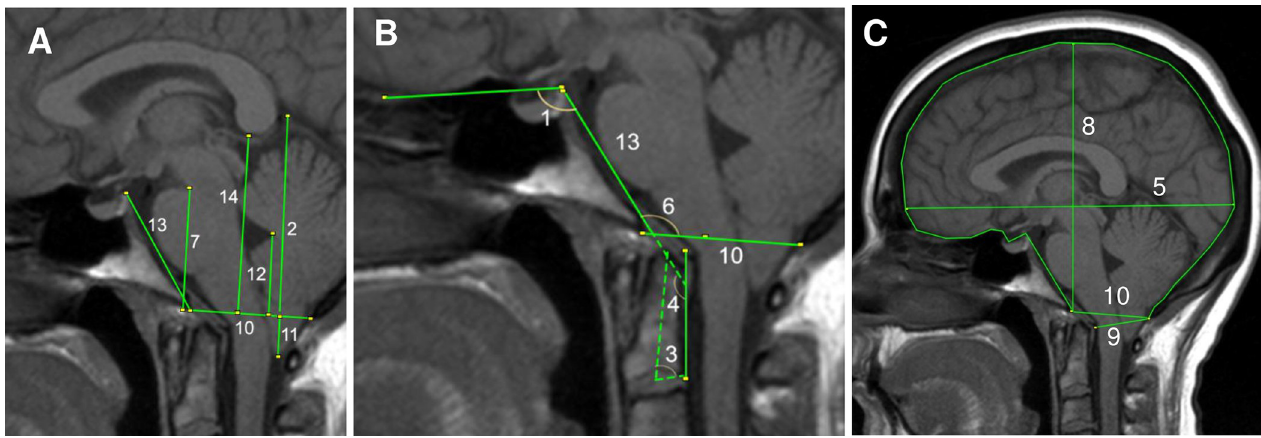
Fig 3. Fourteen morphometric measurements taken on a midsagittal T1-weighted MRI. A: 2-Posterior cranial fossa height, 7-pons height, 10- McRae line length, 11-tonsillar position, 12- fastigium height, 13- clivus length, 14-corpus callosum height. B: 1-Basal angle, 3-odontoid angle, 4-Wackenheim angle, 6- Boogard angle. C: 5-intracranial diameter, 8- intracranial height, 9-anteroposterior diameter dura-opisthion. https://doi.org/10.1371/journal.pone.0272725.g003 mm for lengths and 1 degree for angles) was approximately 2 mm (Fig 4). For each subject, the parasagittal distance at which the absolute parasagittal error exceeded 1 unit was identified for each morphometric parameter on both left and right sides of the midsagittal plane. An average value was found using the data for five subjects, for each morphometric parameter. The data on the left is the average lateral distance at which the parasagittal error exceeds 1 unit on the left side of the midsagittal plane, and the data on the right is the average lateral distance at which the parasagittal error exceeds 1 unit on the right side of the midsagittal plane.